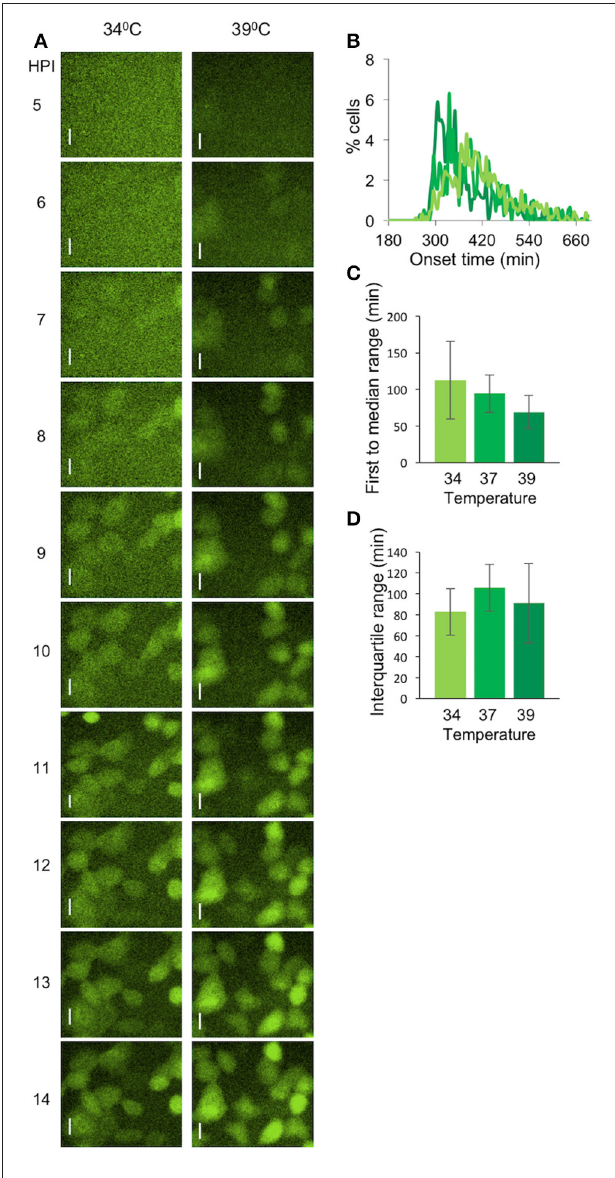
FIGURE 7 | Variability of viral late gene expression exhibit temperature dependent. (A) Cells were infected with OK19 recombinant virus at MOI 20 and incubated at either 34 ◦ C (left) or 39 ◦ C (right). Snapshots at different time points (as indicated) are presented. mVenus fluorescence in green. Scale bar 20 µ m. (B–D) A comparison between the onset times of expression for the infection at different temperatures: 34 ◦ C (light green), 37 ◦ C (green), and 39 ◦ C (dark green). (B) The average histograms for each condition were plotted. six wells from two experiments done on different days were plotted (C) The time between the first cell onset of expression to the median cell onset (first to median range) was plotted for each condition. (D) The interquartile range was plotted for each condition. (B–D) Error bars represent the standard deviation among the different